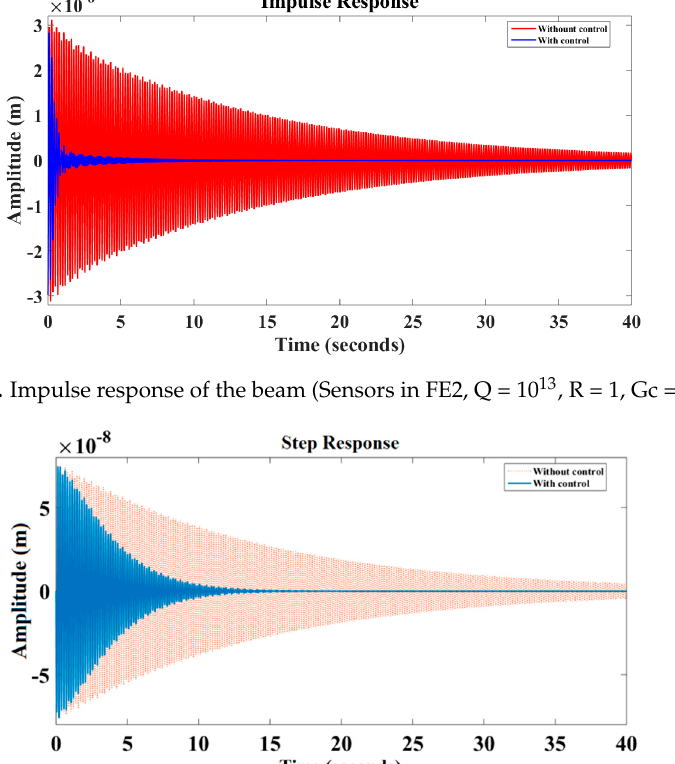
Figure 7. Impulse response of the beam (Sensors in FE2, Q = 10 11 , R = 1, Gc = 100).